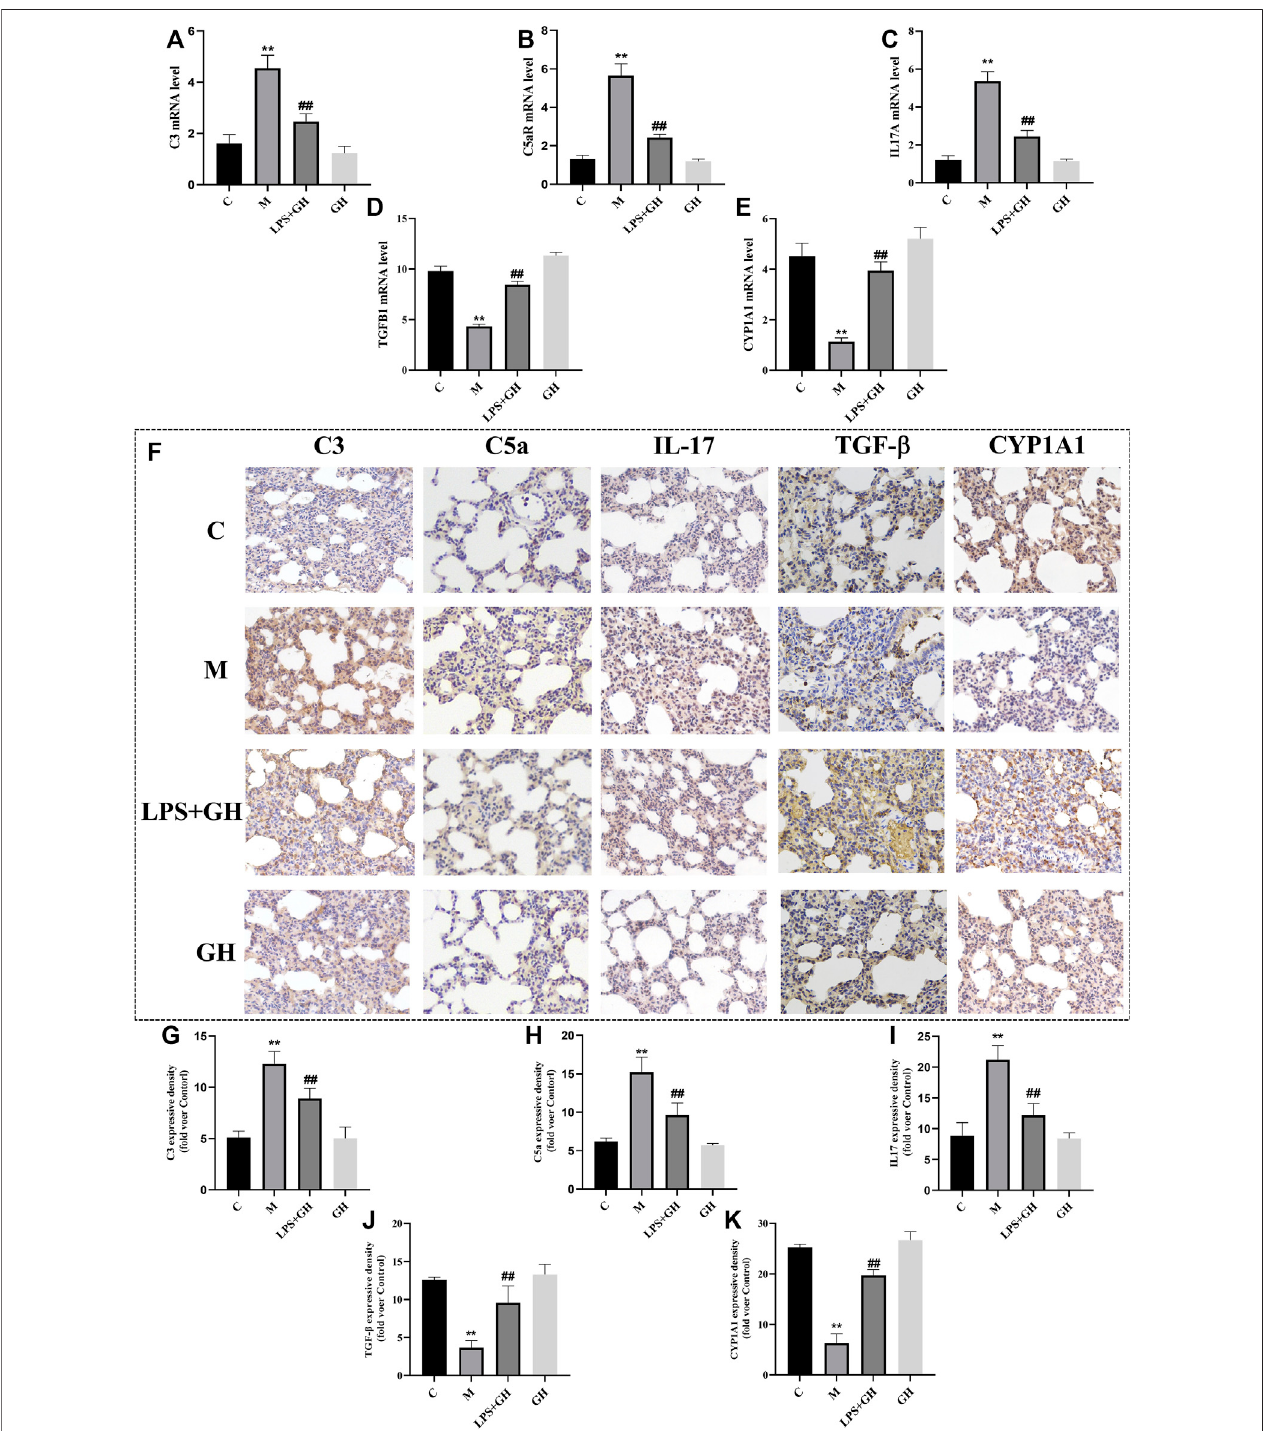
FIGURE 6 | Immunohistochemistry and expression of key targets ( n = 6). (A) The expression level of C3 mRNA. (B) The expression level of C5aR mRNA. (C) The expressionlevelofIL-17AmRNA. (D) TheexpressionlevelofTGF- β 1mRNA. (E) TheexpressionlevelofCYP1A1mRNA. (F) Immunohistochemicalresultsofeachgroup (Magni fi cation ×400). (G) Expression of C3 protein. (H) Expression of C5a protein. (I) Expression of IL-17 protein. (J) Expression of TGF- β protein. (K) Expression of CYP1A1 protein. Compared with the control group, ** p < 0.01. Compare with model group, ## p < 0.01.